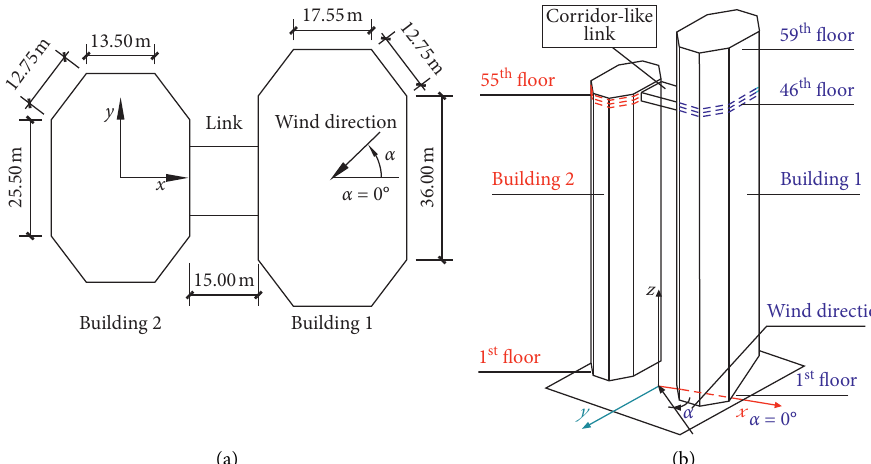
Figure 2: (a) Plane view of adjacent buildings and definition of the coordinate system and wind direction [8] and (b) axonometric sketch of two buildings [43].